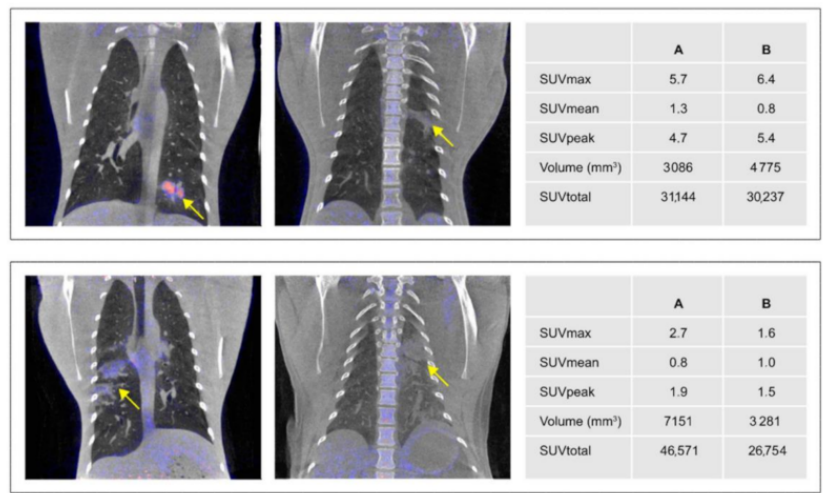
Figure 8. Two rows of images, each illustrating two different manifestations (A and B) of a bacterial infection (upper row) and a viral infection (bottom row). The respective lesions are indicated by the yellow arrows. Representative output parameters are shown on the right for the left (A) and the right (B) images, respectively. Similar window-level settings are applied to all